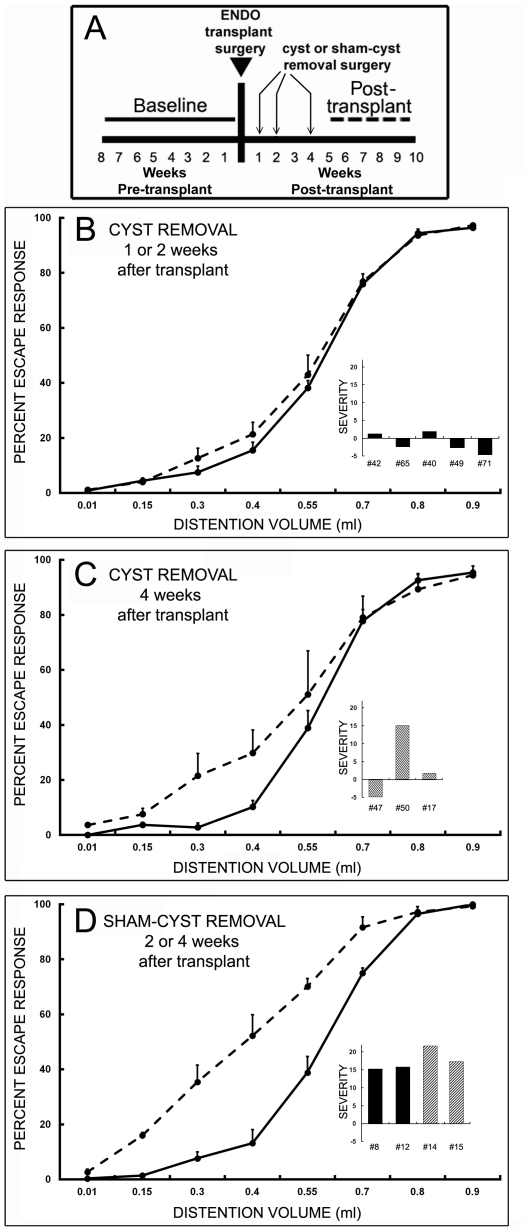
Effect of cyst removal or sham-cyst removal performed before the cysts acquire mature innervation on the development of vaginal hyperalgesia.
A. This diagram depicts the time-course of experimental testing (baseline, post-transplant) and surgical procedures (1, 2 or 4 weeks after transplant). B–D. The graphs show percent escape response as a function of vaginal distention volume before (baseline, solid line) and 5–10 weeks after transplant surgery (dashed line). Error bars are ± SEM. The inset bar graphs depict the severity of hyperalgesia individually for each rat in that group (as in Fig. 1). Solid bars indicate cyst removal or sham-cyst removal at 1 or 2 weeks post-transplant; the hatched bars indicate cyst removal or sham-cyst removal at 4 weeks post-transplant. B. Pre-innervation cyst removal (1 or 2 weeks post-transplant) prevents the development of hyperalgesia (n = 5). C. When cyst removal is performed just after innervation has become active, but before innervation is mature; i.e., 4 weeks post-transplant, the development of hyperalgesia is prevented in two of three rats. D. In contrast, after sham-cyst removal, regardless of when the surgery is performed relative to the innervation (either 2 or 4 weeks after transplant), hyperalgesia develops in all rats (n = 4).